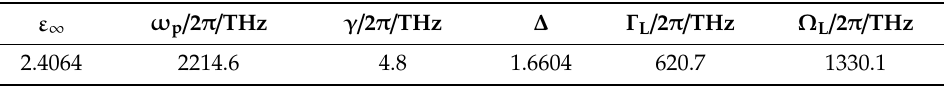
Table 1. Values of the optimized parameters to fit the experimental data of